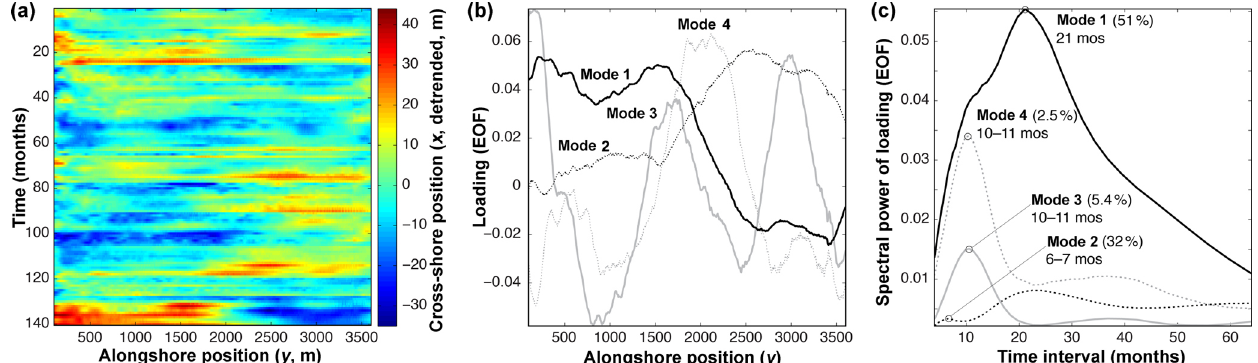
Figure 3. (a) Detrended (in time) shoreline position, measured approximately monthly by quad bike, with north at left (corresponding to Fig. 1a). (b) Orthogonal PCA modes (or empirical orthogonal function (EOF) modes), representing variance about the mean shoreline position, and (c) wavelet-derived power spectra of each mode, where the first local maximum indicates the characteristic timescale for that mode.